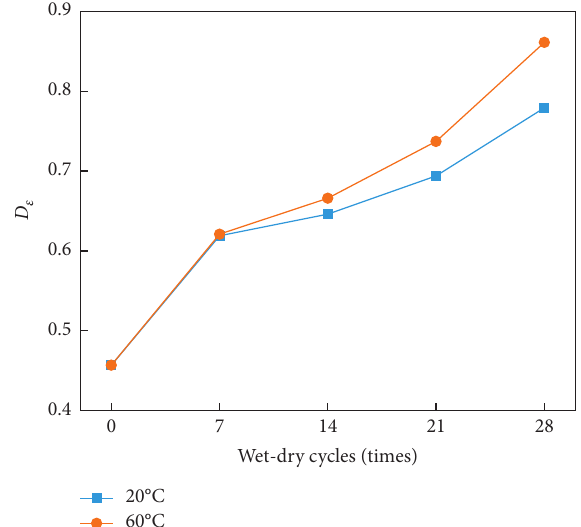
Figure 11: Damage variable D ε of RC subjected to different wet-dry cycles.